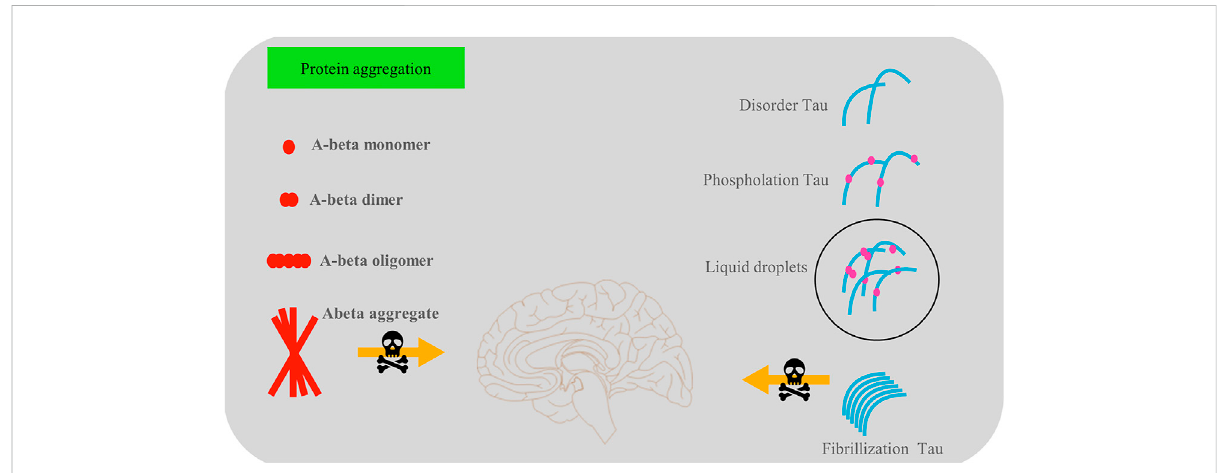
FIGURE 1 Therearetwomain types ofproteinaggregation — phosphorylated tauproteinand amyloid- β proteinaggregations,which playavital roleinthe development of dementia. Soluble amyloid- β is bene fi cial in memory and synaptic transmissions among cells, but amyloid- β aggregations are harmful to cell survival. The tau protein interferes with the normal activities of nerve cells in a variety of ways, such as by reducing microtubule